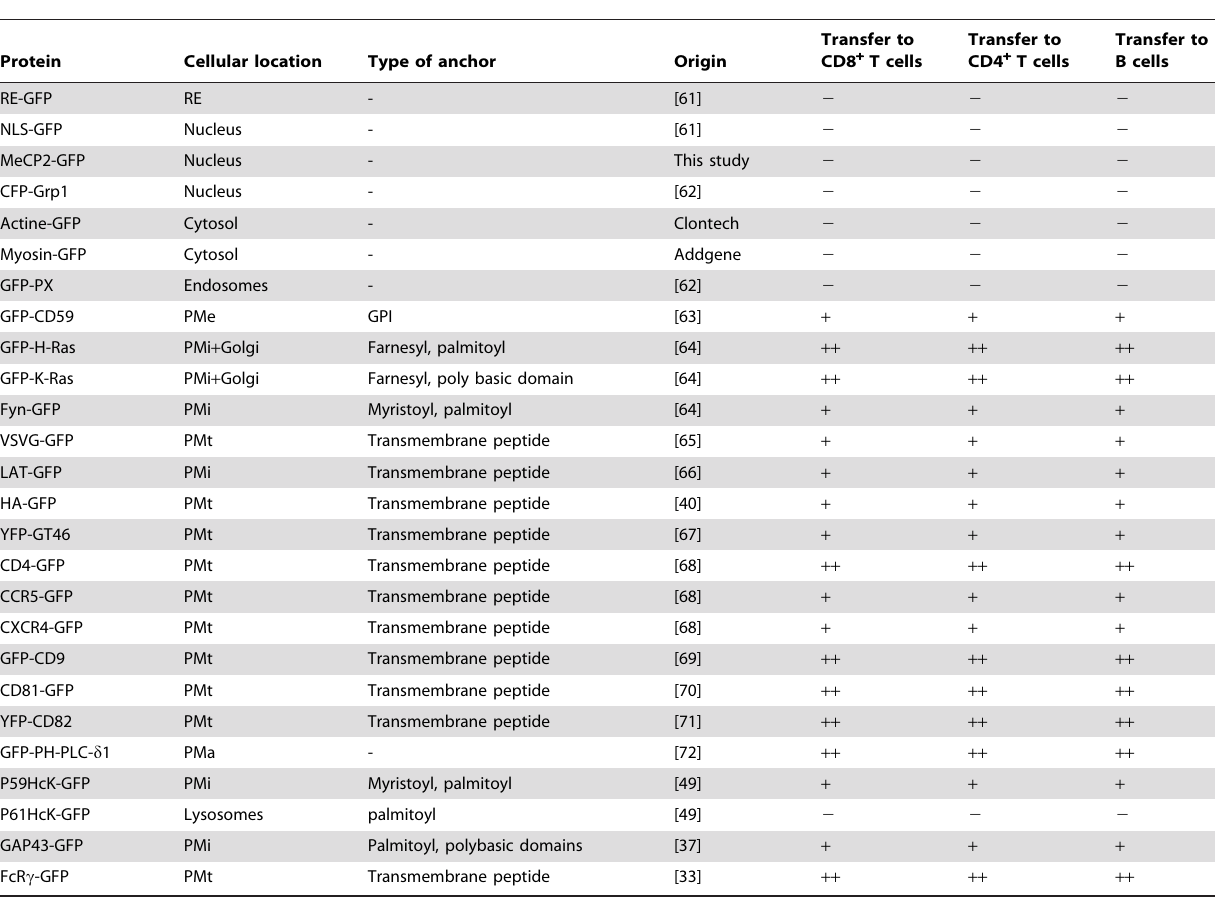
Table 1. Summary of the characteristics of the fluorescent proteins initially used in this